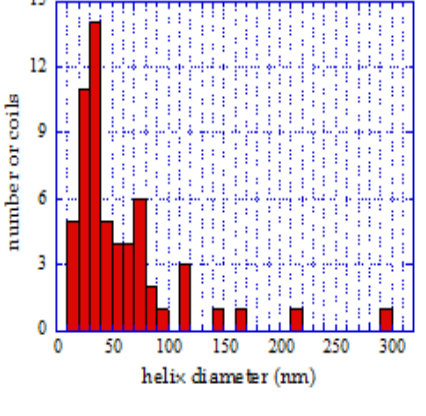
Figure 9. Distribution of diameters, helix pitch, and correlation between pitch and diameter at pH = 10. Reproduced from [25] with